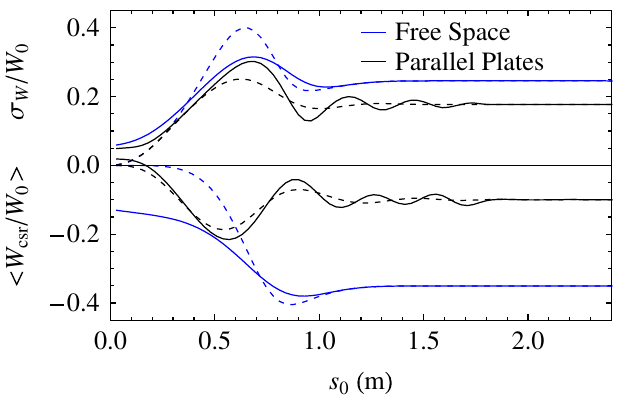
FIG. 12. (Color) The average energy loss and energy spread induced, per unit length, of the CSR wake for a Gaussian bunch through the length of a bend in free space as well as between parallel plates with H ¼ 2 cm . Solid lines have D ! 1 . Parameters used are (cid:7) (cid:1) 1 dashed lines have D 1 10 m , (cid:10) z ¼ 0 : 3 mm , with an energy of 1 GeV.